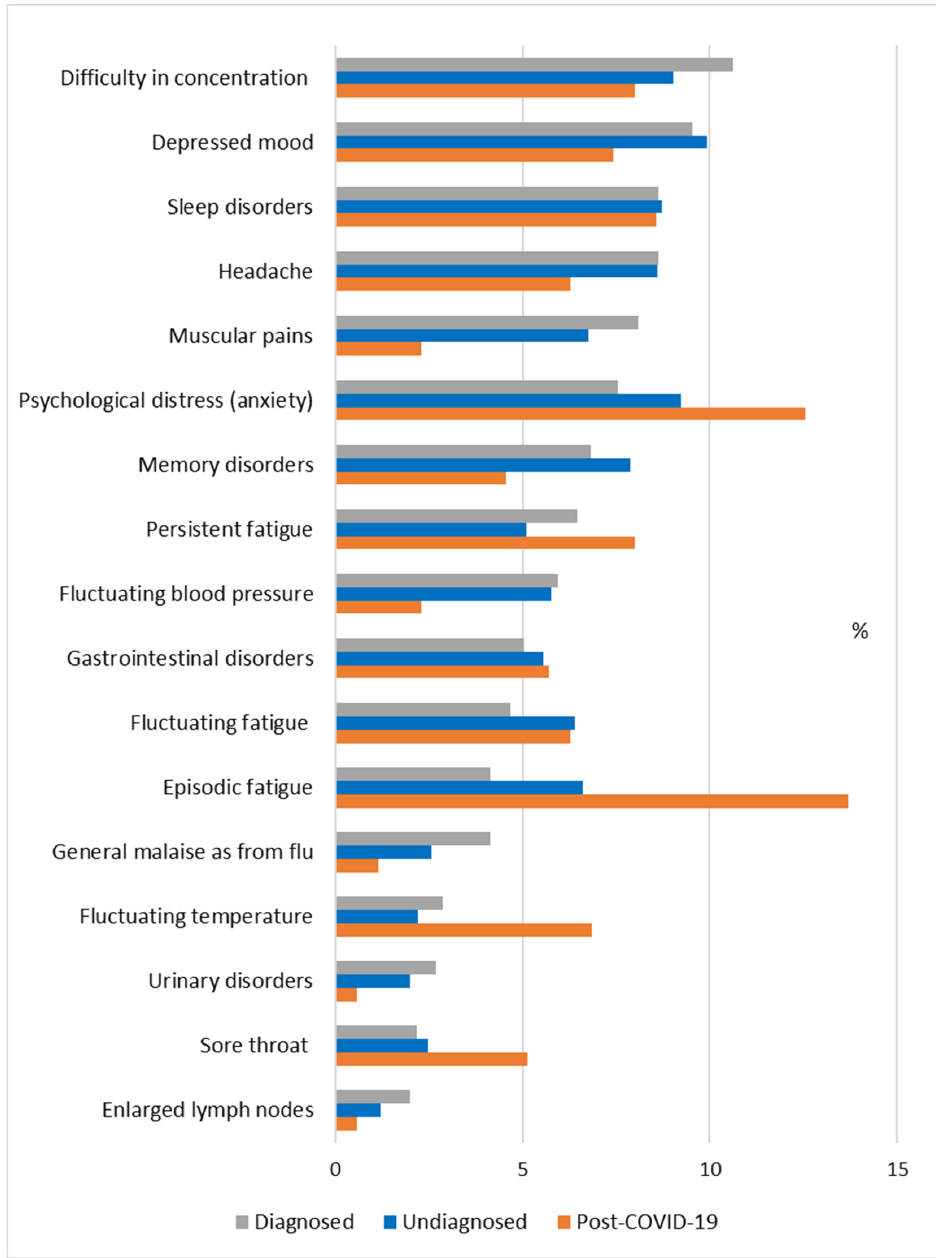
Figure 5. The prevalence of symptoms reported by ME/CFS patients and undiagnosed patients prior to COVID-19 (the first survey), and by former COVID-19 patients 6 months after infection (the second survey), as a percentage of the total number of reported cases of symptoms in each group. The data show (Figure 5) that the predominant symptom in ME/CFS patients is “dif- ficulty concentrating”, while in undiagnosed patients “depressed mood” predominates, and “sleep disorders” puts an equally hard burden on all groups of patients. Significantly, non-diagnosed patients and former COVID-19 patients have noticeably higher levels of “psychological distress (anxiety)” compared to ME/CFS patients. “Muscular pain” and “headache” are vastly less common in former COVID-19 patients, but “sore throat” is substantial. “Memory disorders” occur more in undiagnosed patients. “Fluctuating blood pressure”, “general malaise, as from flu”, “urinary disorders”, and “enlarged lymph